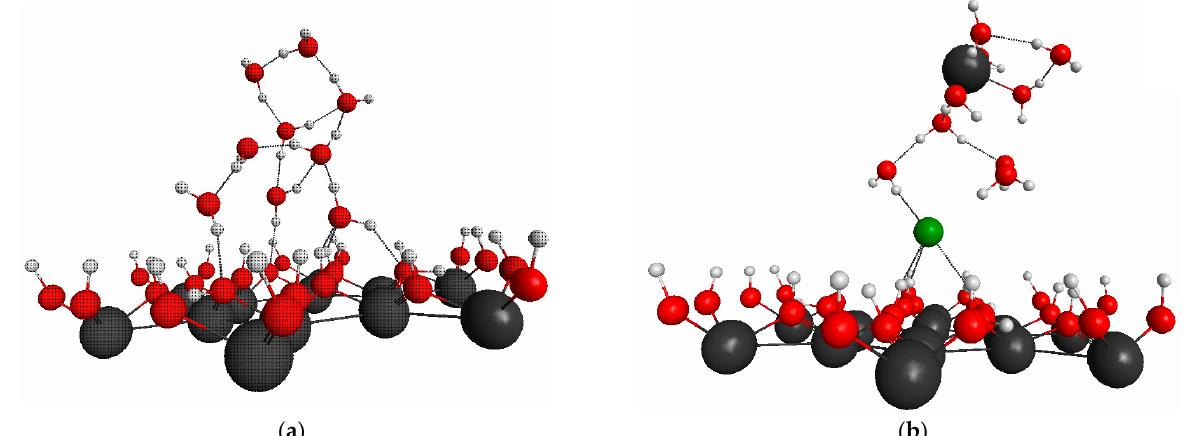
Figure 16. Optimized spatial positions of atoms in the clusters of water ( a ) and sodium chloride solution ( b ) near the hydroxyl surface of kaolinite.